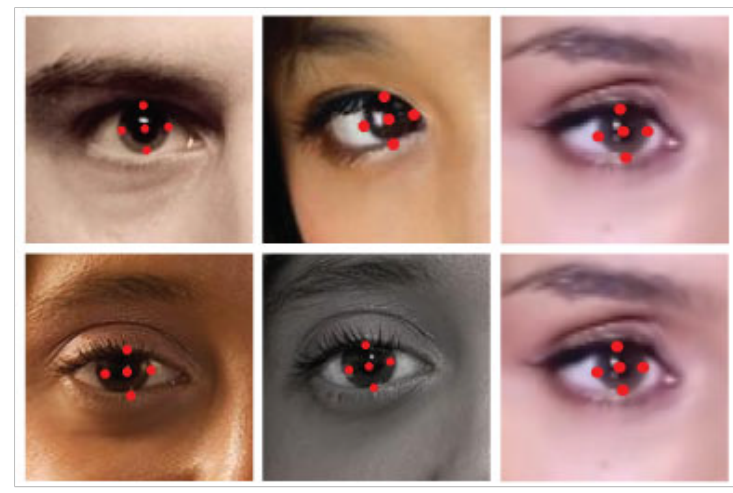
Figure 1. Iris landmark annotation samples.